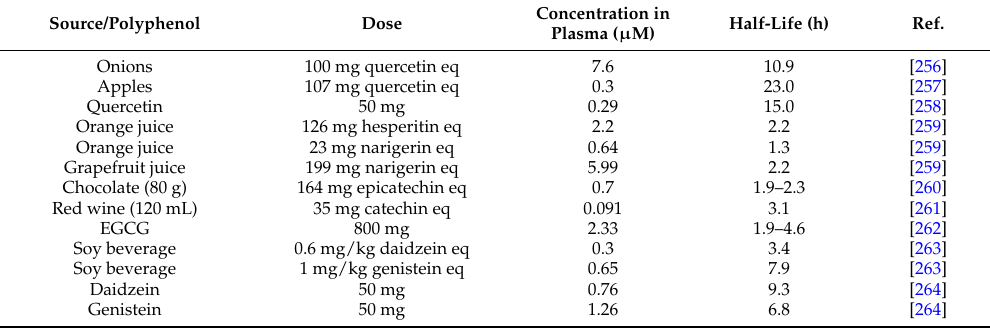
Table 4. Bioavailability of main polyphenols in the human body (adapted from Manach C. et al. ,